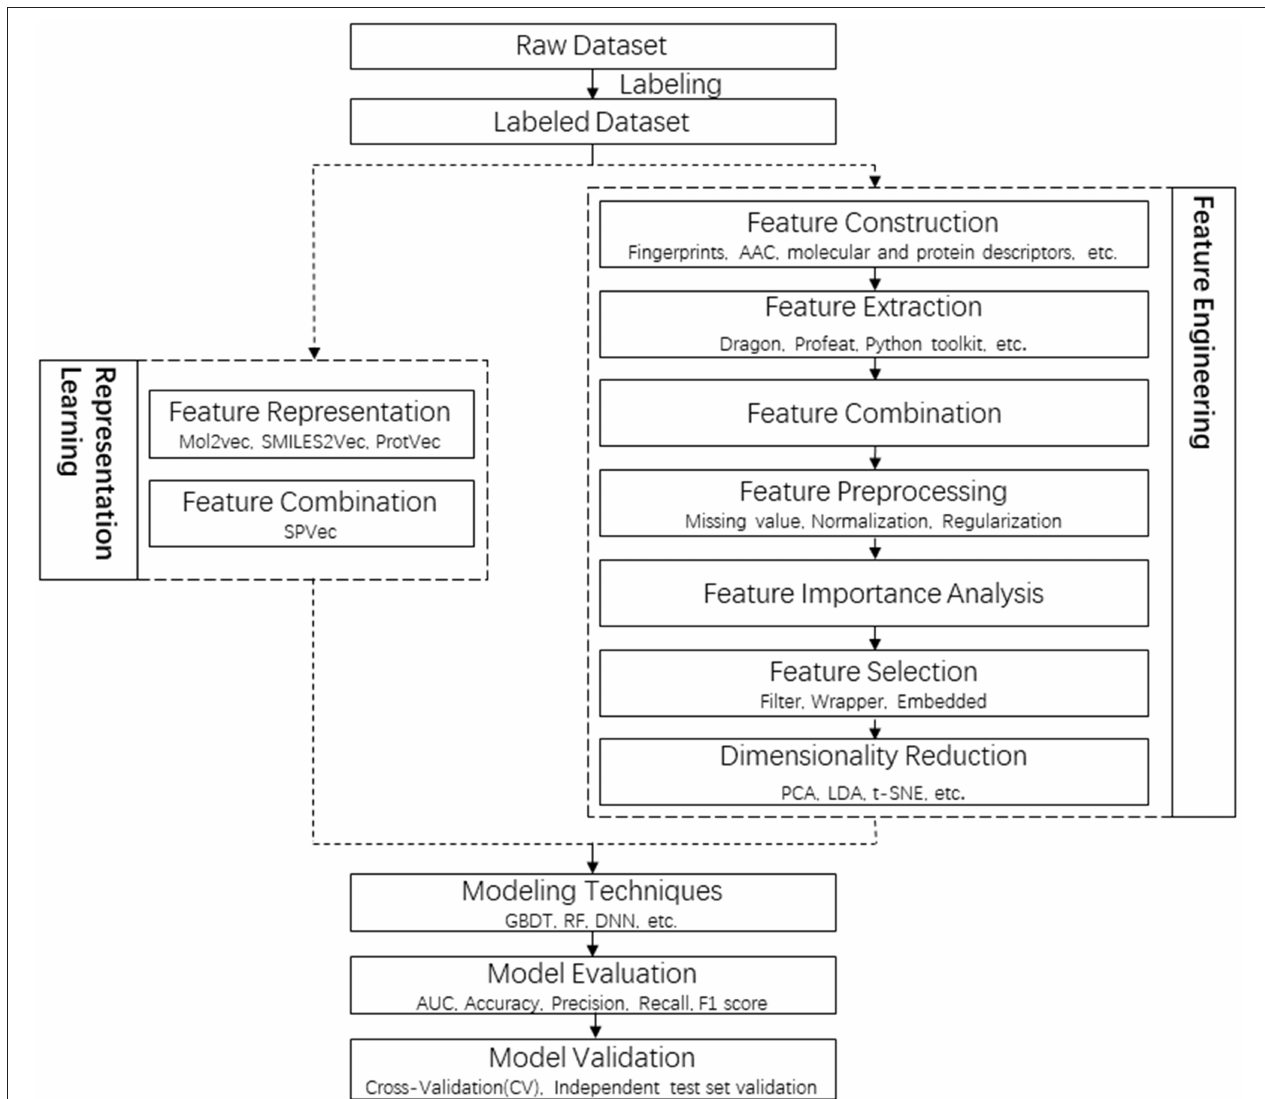
FIGURE 1 | Flowchart of the whole pipeline for DTI prediction in this article (left) in comparison to the traditional pipeline (right) , with the procedures of feature representations squared in dashed lines.